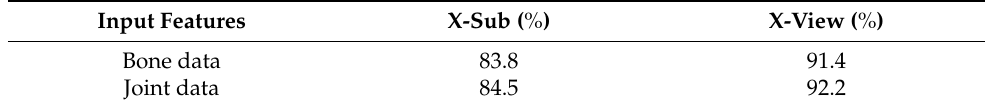
Table 2. Evaluation of STGCN on different input types.